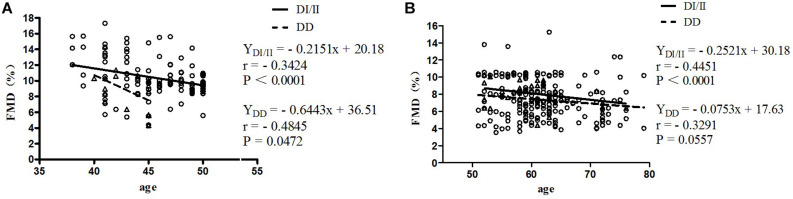
Correlation analysis between FMD and age in women of the pre-menopause group (A) and the post-menopause group (B). FMD, flow-mediated dilatation; DD, homozygous deletion; DI/II, I allele carriers. The subjects were classified as belonging to pre- or post-menopause groups according to their menopause status. Age as the abscissa and FMD as the ordinate, two-dimensional FMD plot of women with different ACE genotypes in different menopause stages were made; linear regression was performed for FMD and age. (A) Pre-menopause group; (B) Post-menopause group.